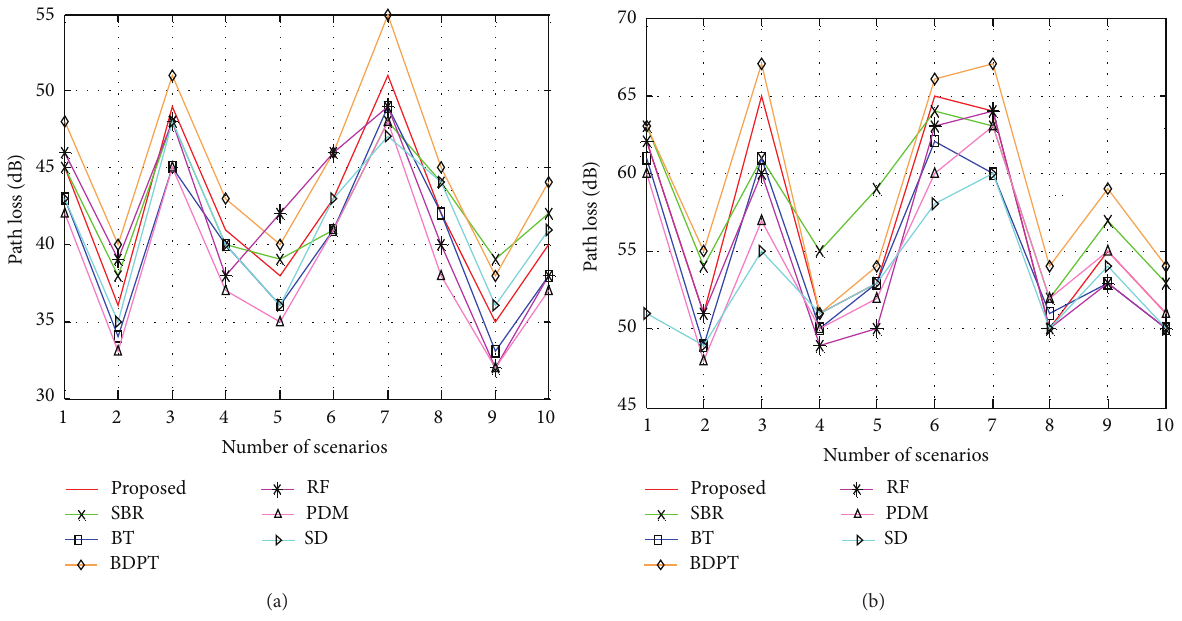
Figure 13: Comparison between the proposed and existing algorithms based on the average path loss for (a) 900 MHz and (b) 2.44 GHz.